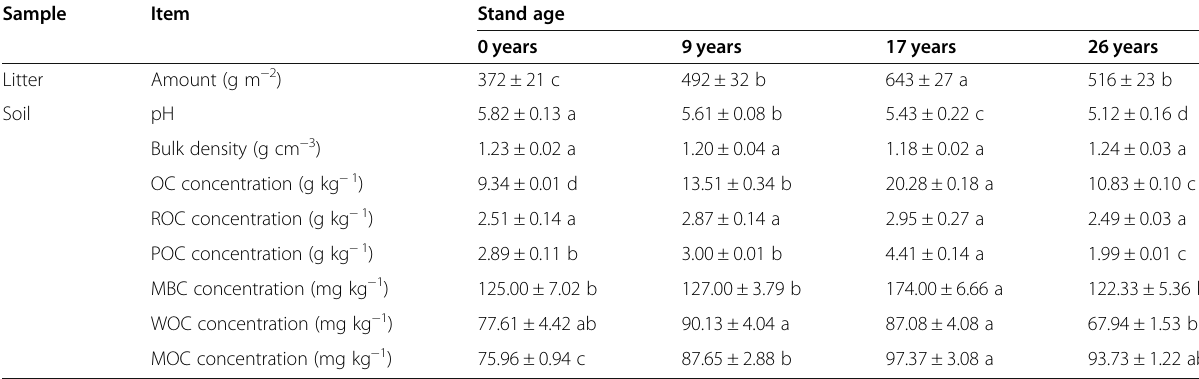
Data represent the average of 3 replicates ± standard errors. Different lowercase letters indicate significant differences among the different stand ages. OC , organic carbon; ROC , readily oxidizable carbon; POC , particulate organic carbon; MBC , microbial biomass carbon; WOC , water-soluble organic carbon; MOC , mineralized organic